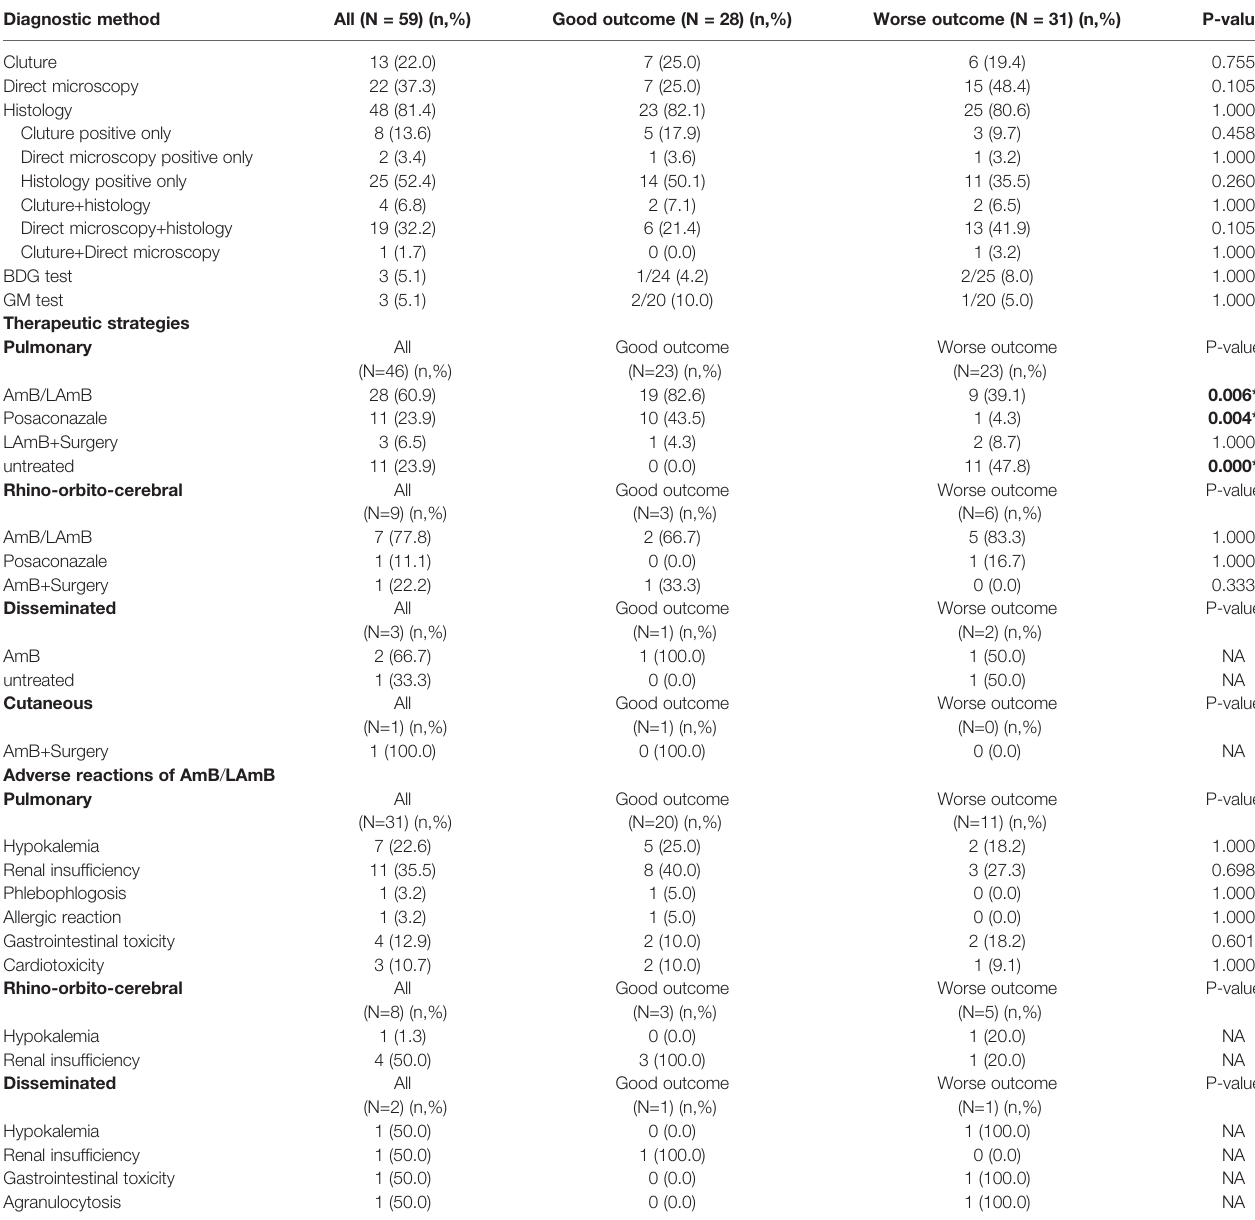
TABLE 4 | Diagnostic procedures and treatment strategies for proven patients with mucormycosis . Diagnostic